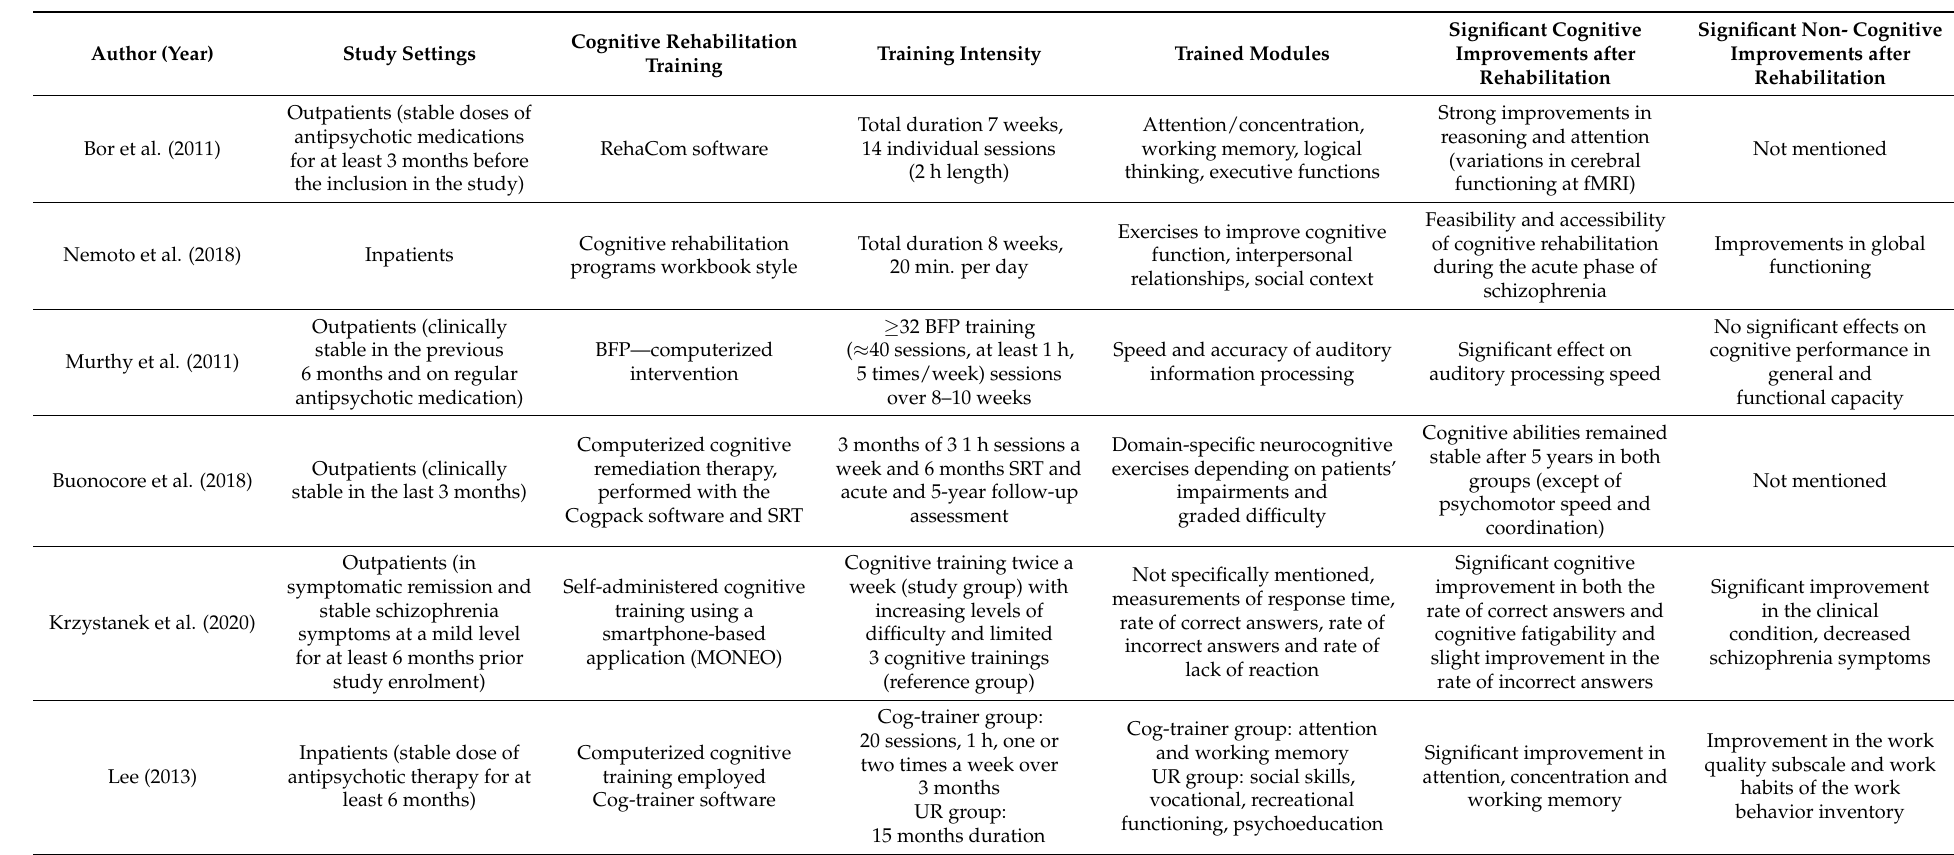
Table 2. Summary table—settings and outcomes of the included